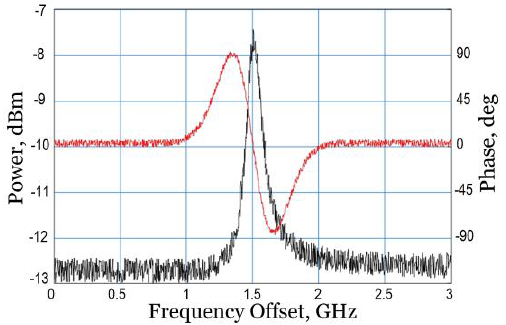
Fig. 3. Frequency responses of FBG Fano resonance structure: black line – magnitude response; red line – phase